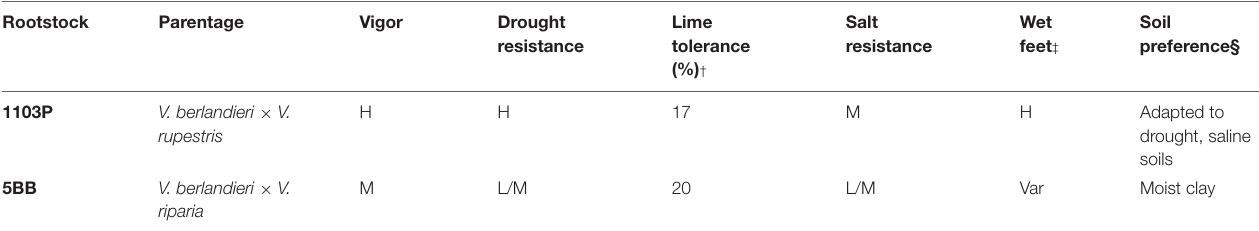
L = low; M = medium; H = high; Var = variable. † Tolerance to lime-induced chlorosis (percent by weight of finely divided calcium carbonate in soil that can be tolerated by the rootstock). ‡ Tolerance to excessive moisture caused by poor soil drainage. §Actual performance characteristics on specific soils and scions may vary. Sources: Adapted from Lambert et al.